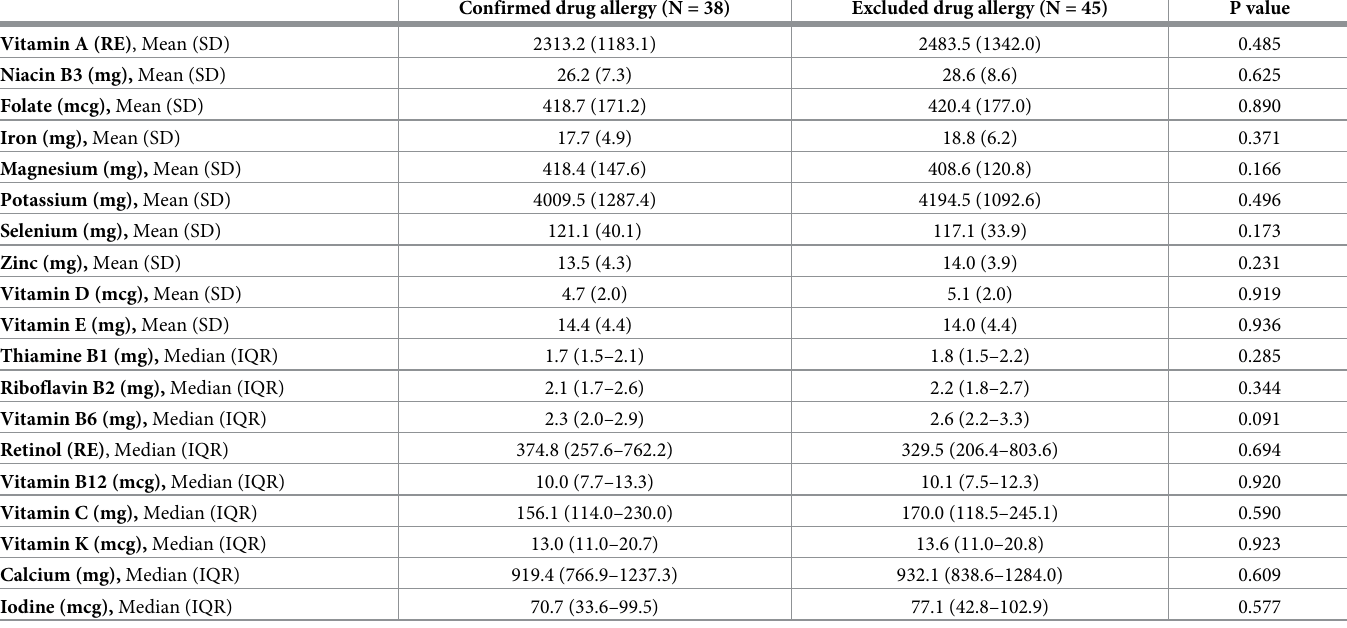
Table 5. Micronutrients intake and drug allergy